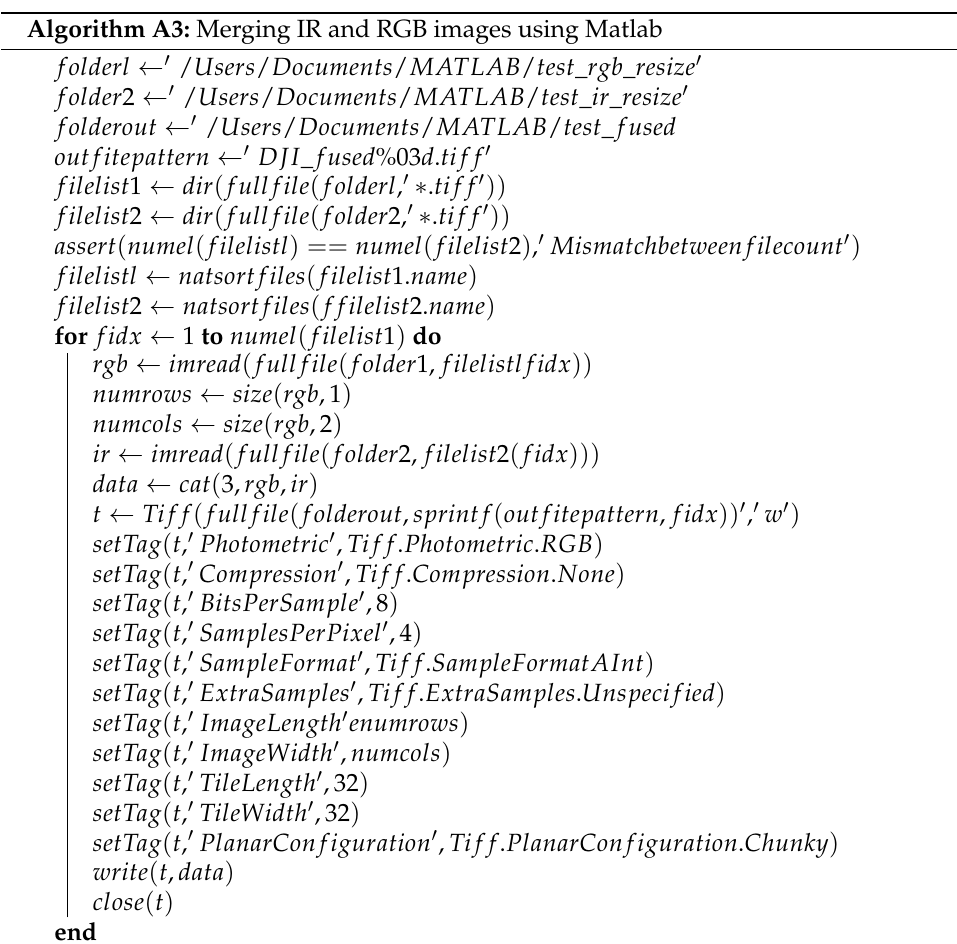
Algorithm A3: Merging IR and RGB images using